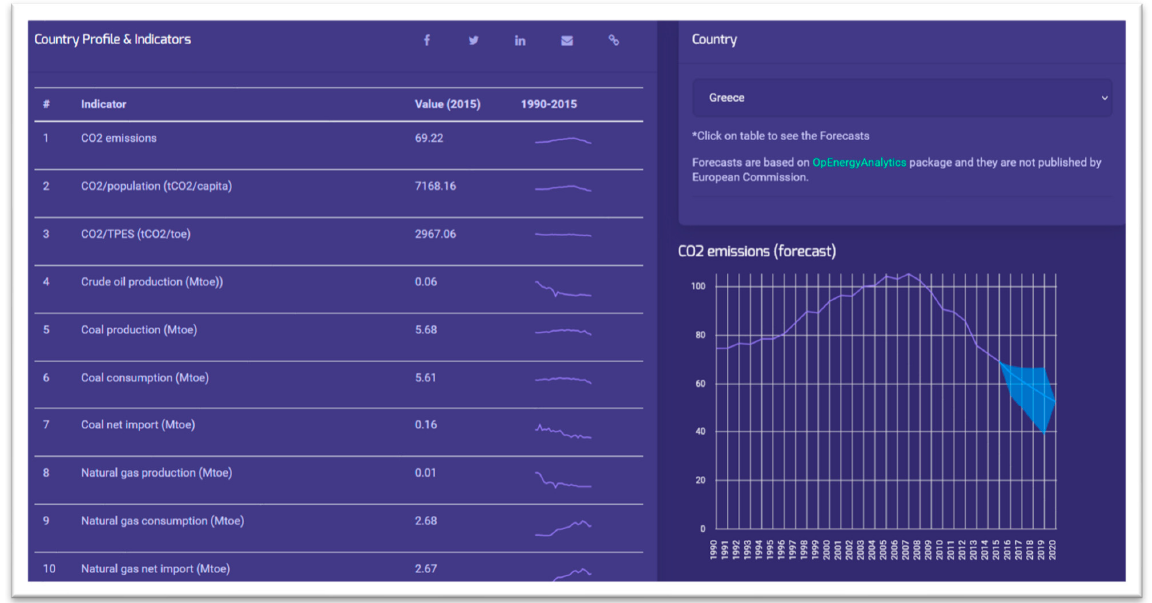
Figure 9. Comparison of market indicators—entities bringing gas into EU countries. Similar to the EU Energy Targets page, there is a time series chart of a selected coun- try for a selected indicator with the forecasts of the indicator’s values along with its con- fidence intervals. The treemap is used to display data that is nested in a hierarchical structure and can capture relative sizes of indicator subcategories, showing factors that are large contribu- tors to each category. Color can identify factors that are under- or over-performing com- pared to other factors from the same category (Figure 10).